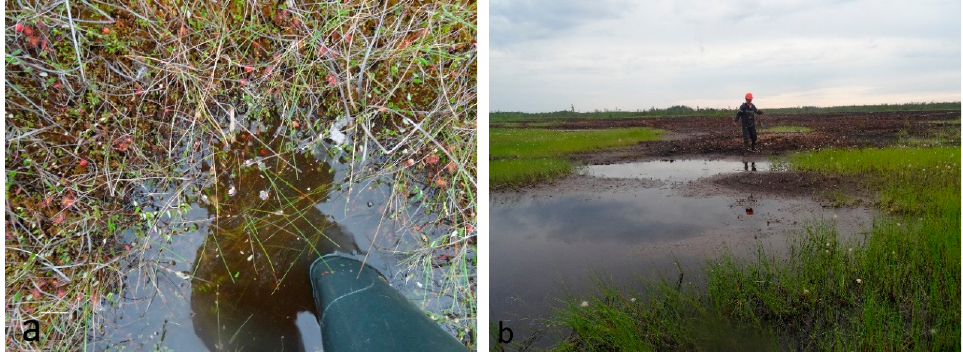
Figure 2. Study sites in the sphagnum bogs of the Ershov oil field in the Vakh River basin: site 1, referenced ( a ); site 7, polluted by mineral oil ( b ).